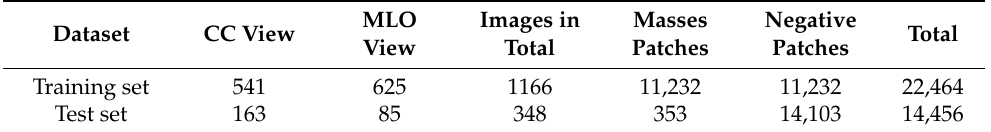
Table 1. Information on the CBIS-DDSM